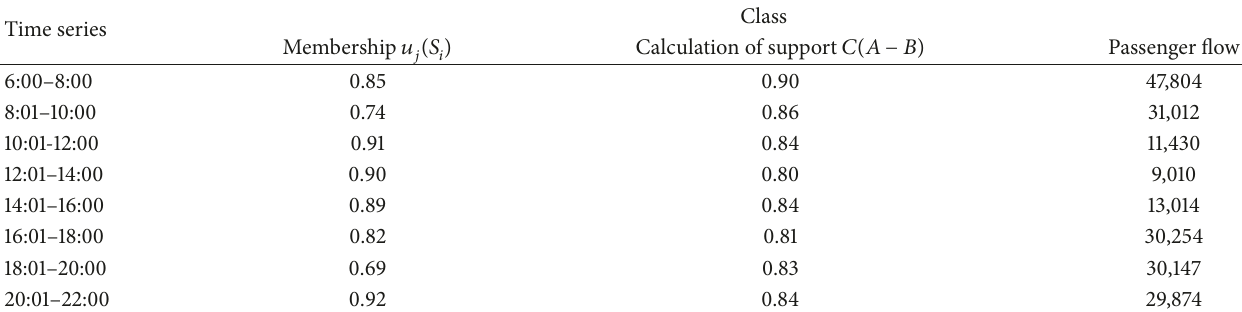
Table 3: Characteristic values of 2-hour particle size of Da Xue Cheng Station.